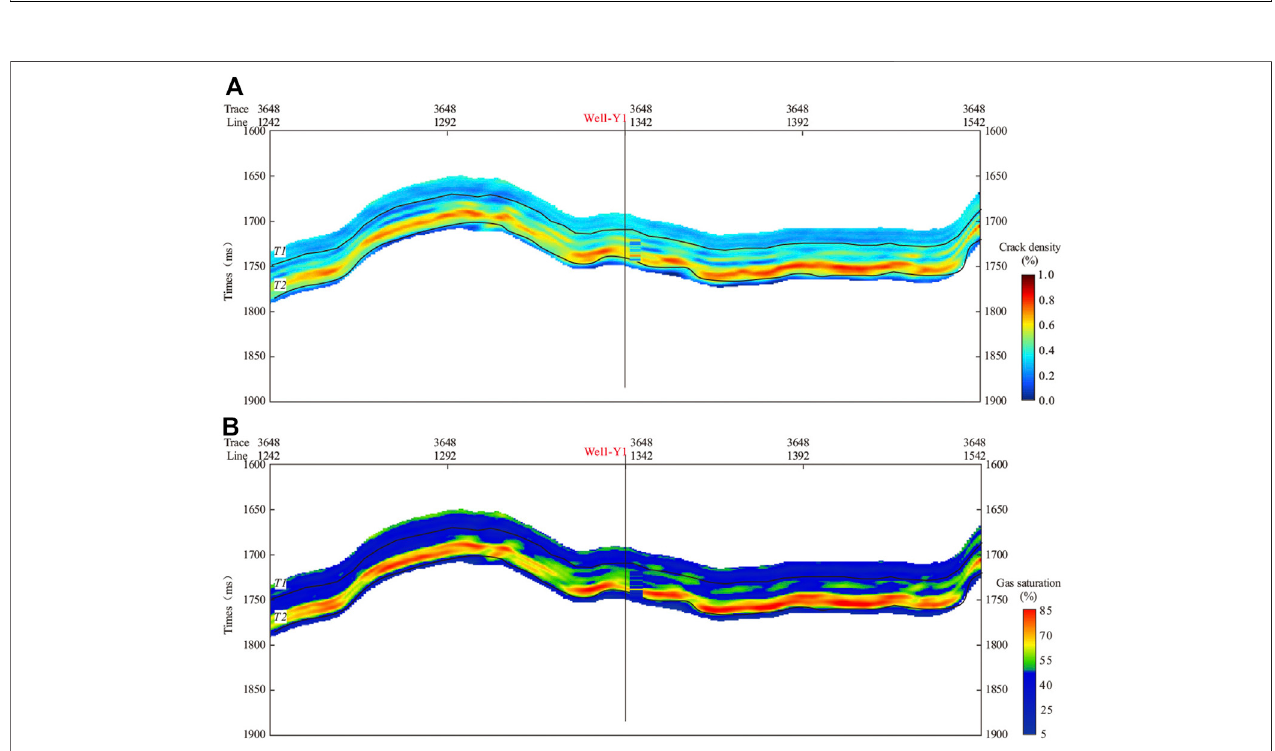
FIGURE10 | By projectingthe inversion results in Figure 9 onto therock physics template in Figures 7 , 8 ,we obtain the interpreted sections of (A) crack density, and (B) gas saturation.